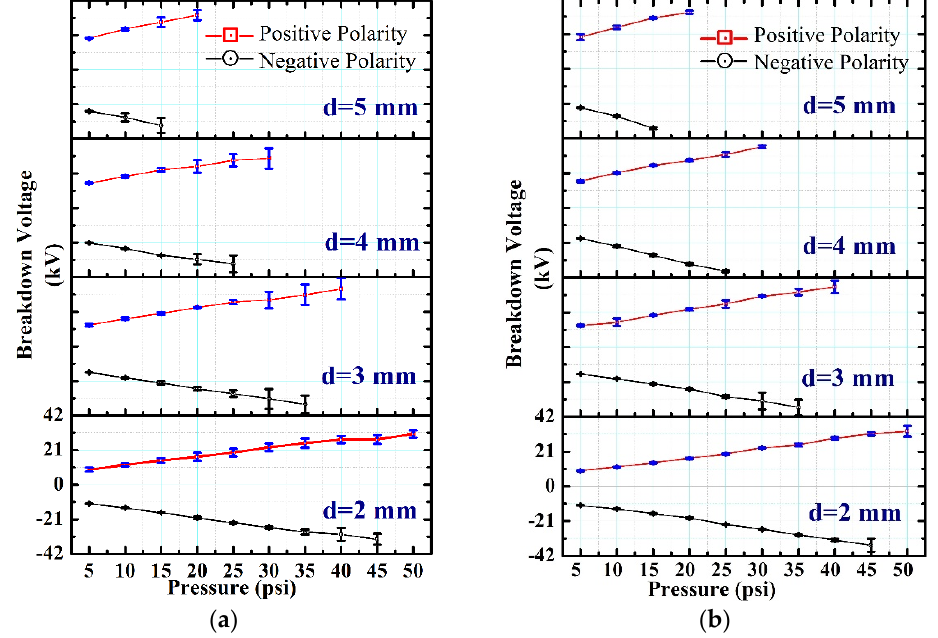
Figure 13. Results of Plane-Parallel and Hemi-sphere profiles. ( a ) Plane Parallel. ( b ) Hemi-Sphere.